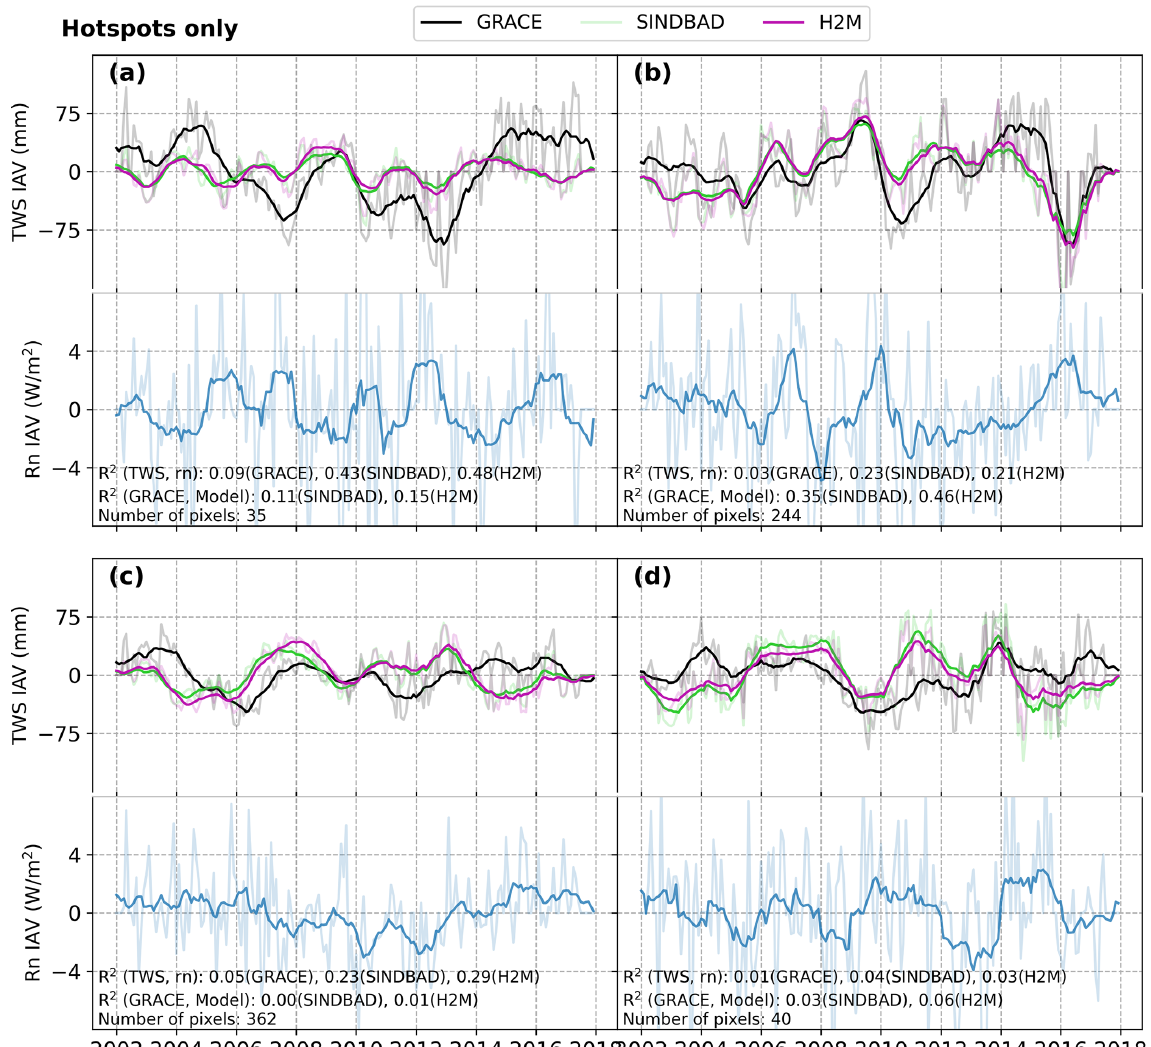
Figure B10. Same as Fig. 6 but using net radiation ( R n ) IAV instead of PPT IAV.